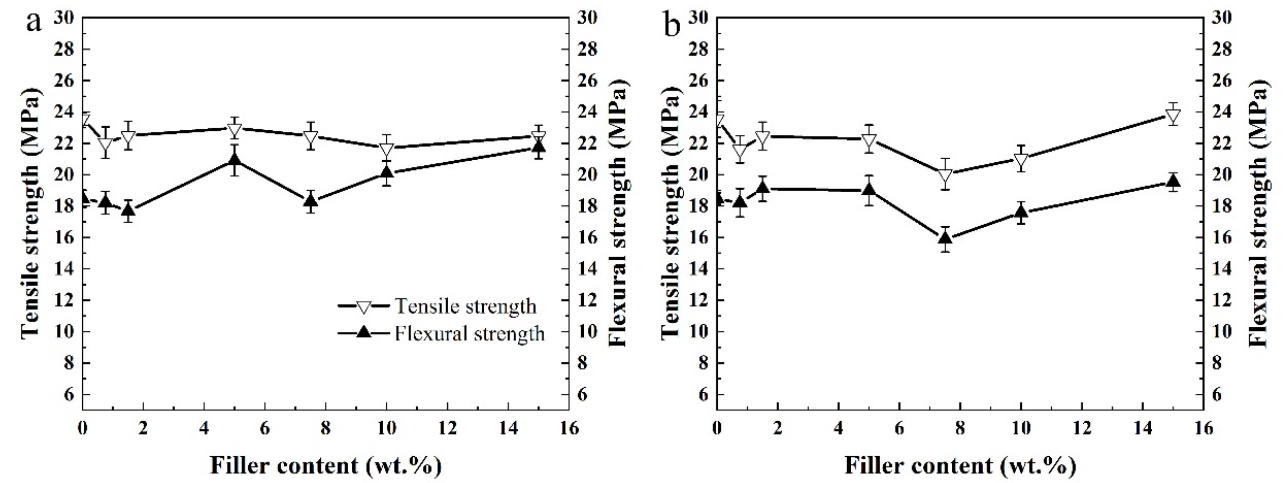
Figure 7. Mechanical properties of pure HDPE and HDPE composites: ( a ) WRHA as fillers and ( b ) ARHA as fillers.